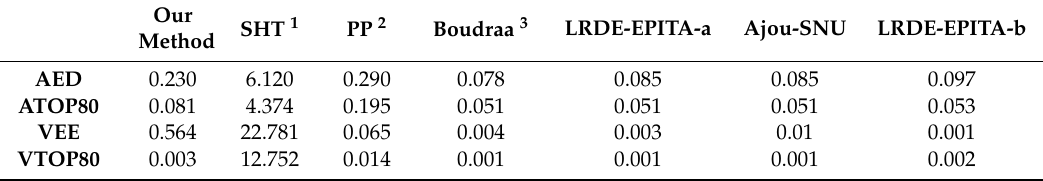
Table 5. Absolute Degree ( ◦ ) of the seven tested methods applied to the document dataset. Our SHT 1 PP 2 Boudraa Method